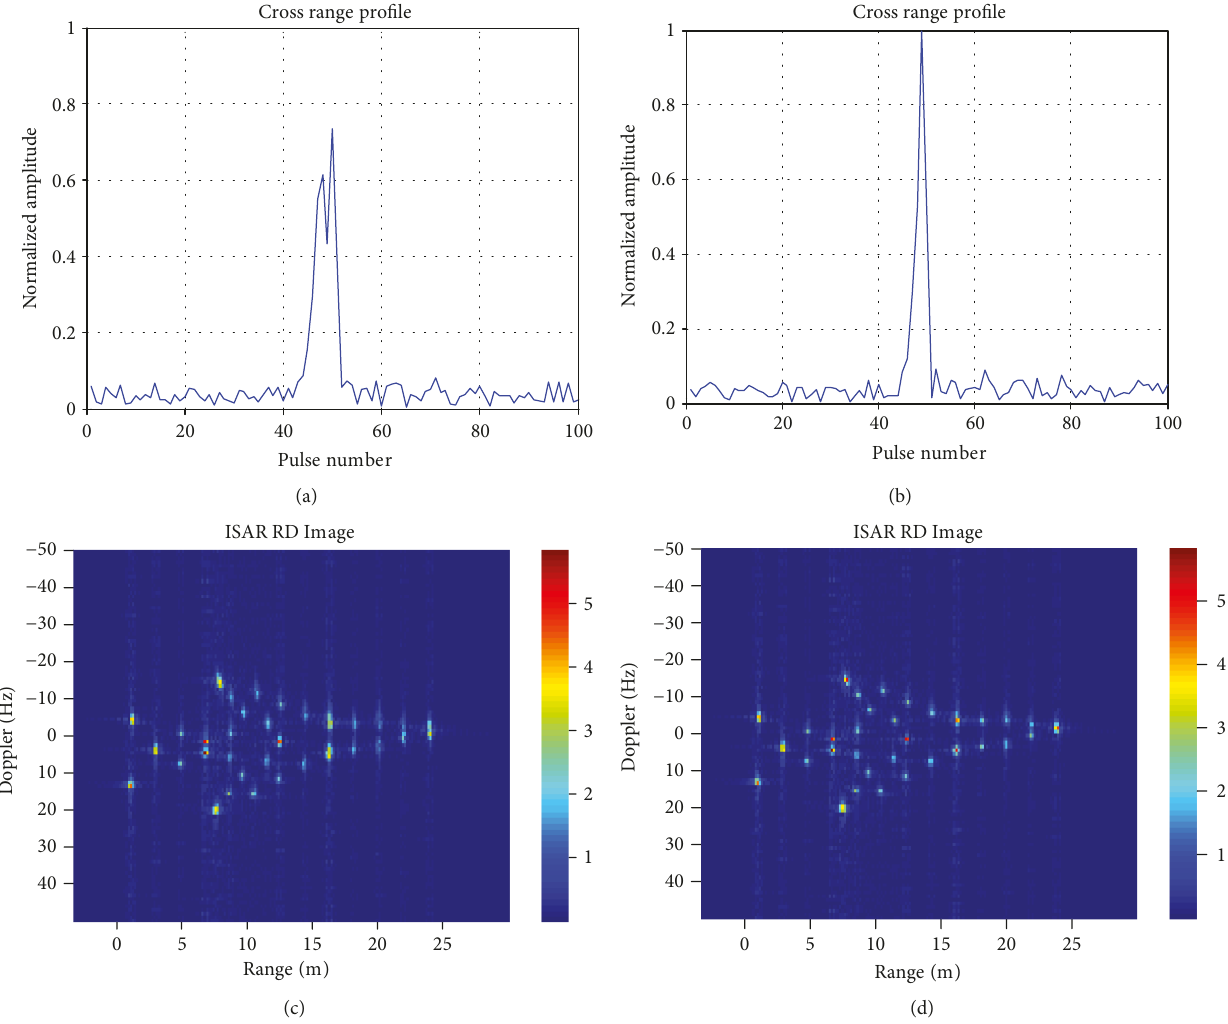
Figure 5: Imaging results of the cross-range pro fi le (a) before and (b) after Doppler compensation, and imaging results of the Range-Doppler algorithm (RDA) imaging result (c) before and (d) after Doppler compensation. Table 1: Image entropy. Figure Image